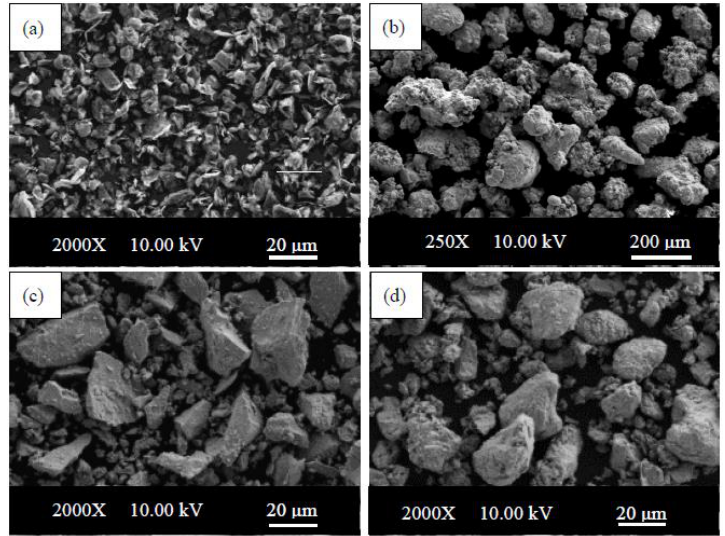
Figure 1. Scanning electron microscope ( SEM) micrographs of powders; ( a ) graphite (<20 μm, 2000× magnification), ( b ) Fe (≤180 μm, 250× magnification), ( c ) Nb (<45 μm, 2000× magnification) and ( d ) V (<44 µm, 2000× magnification).